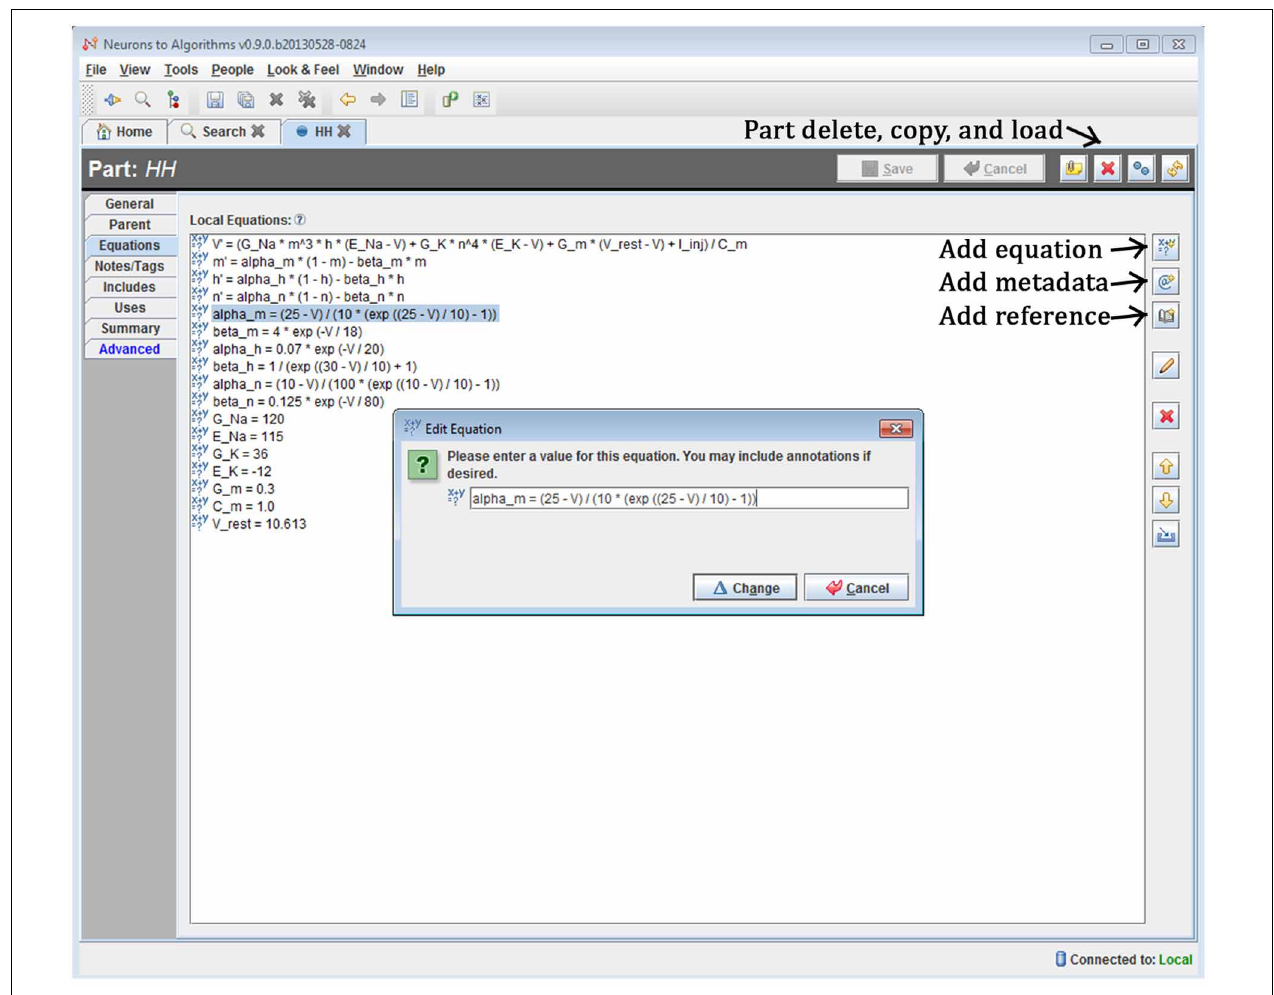
FIGURE 4 | Screenshot of N2A User Interface. The N2A application allows users to create and edit equation sets for parts, define how they connect within a model, and incorporate metadata and references regarding literature